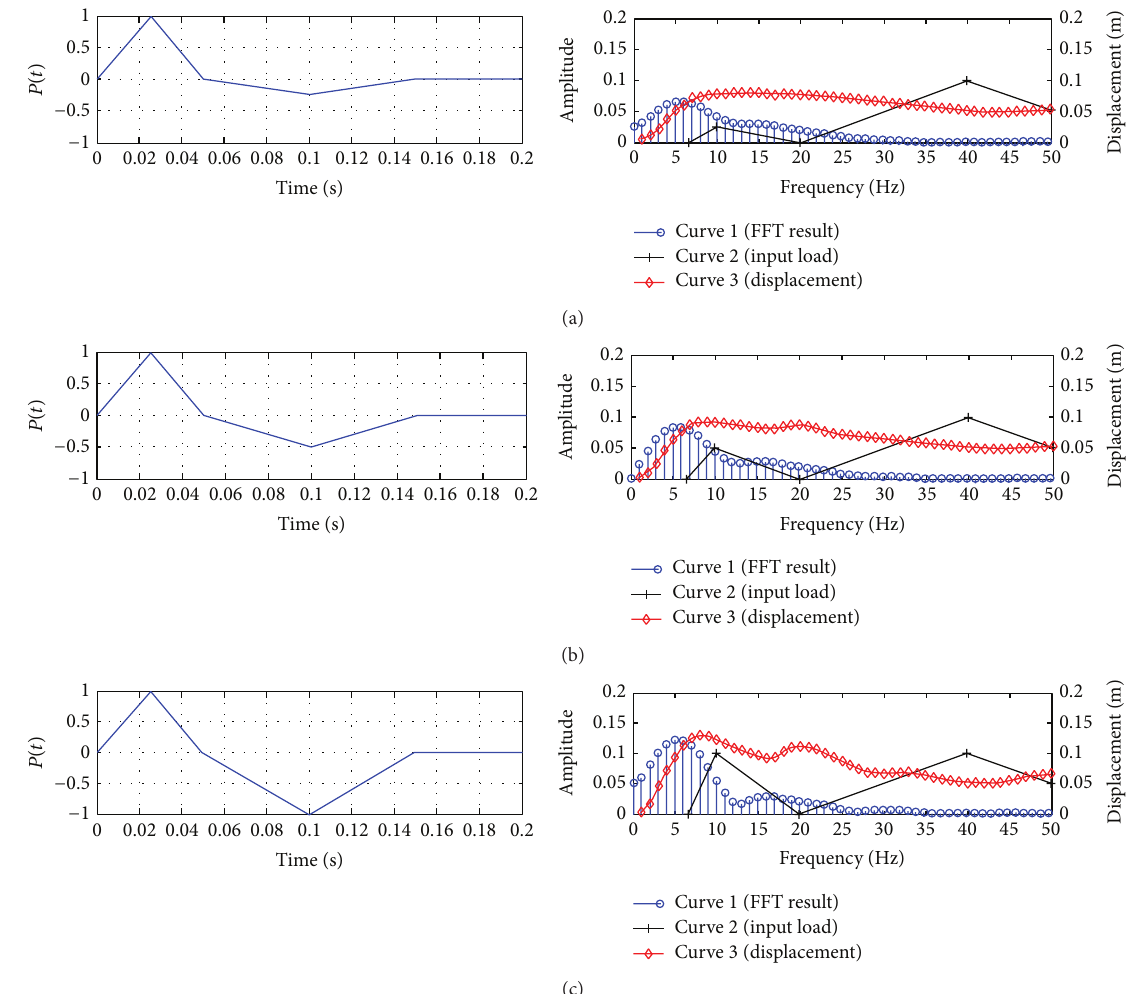
Figure 7: Fast Fourier Transform analysis considering the magnitude of maximum load in negative pressure phase. (a) Standard data. (b) Increasing the 2 times of negative maximum load. (c) Increasing the 4 times of negative maximum load.